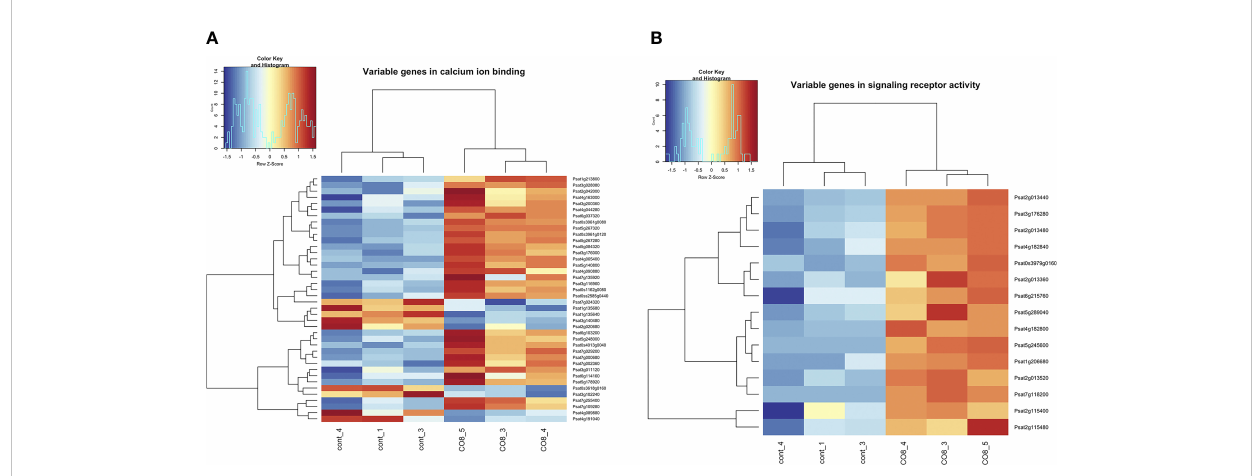
FIGURE 4 Heatmap of gene expression levels after CO8-DA treatment (3 biological replicas) in comparison to control (Jensen ’ s medium) (3 biological replicas). The list of genes that changed expression levels and were annotated in Gene Ontology terms as a part of “ calcium ion binding ” (A) and “ signaling receptor activity ” (B) biological processes in pea roots 24 h after